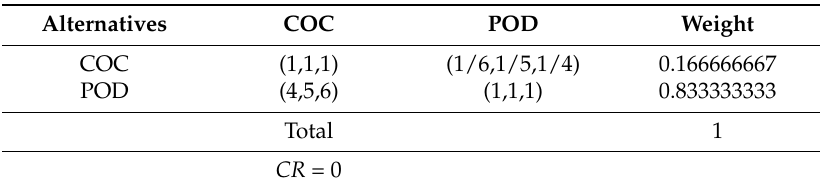
Table A17. Comparison matrix for